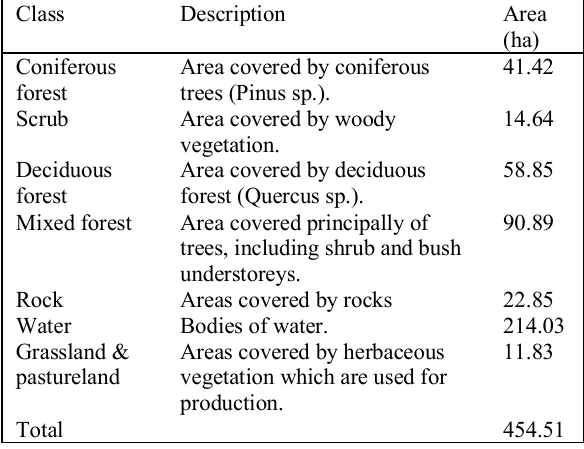
Table 2 . Description of LCLU types by year of study.